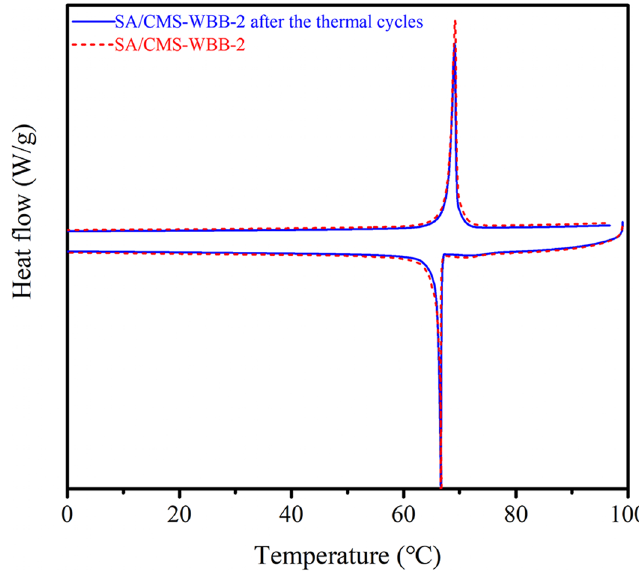
Figure 11. DSC patterns of SA/CMS-WBB-2 before and after thermal cycles.